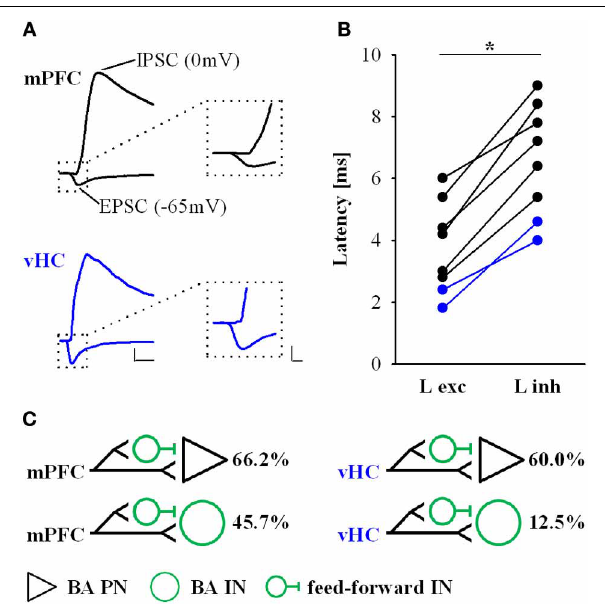
FIGURE 5 | Latencies of EPSCs and IPSCs for mPFC and vHC inputs onto BA neurons. (A) Example traces of EPSCs and IPSCs recorded at − 65mV and 0mV, respectively in Cs-based internal solution. Black traces represent mPFC inputs, blue traces vHC inputs onto BA PNs. Scale bar left: 200pA/10ms; right: 200pA/2ms. (B) Individual data points show a within-cell comparison of latencies of EPSCs (L exc) and IPSCs (L inh) in BA PNs for mPFC ( n = 6) and vHC ( n = 2) inputs. IPSC latencies were significantly slower that EPSC latencies (paired Students t -test: ∗ p < 0 . 01). (C) Proposed wiring scheme of excitatory and feedforward inhibitory connections from mPFC and vHC with neurons in the BA based on